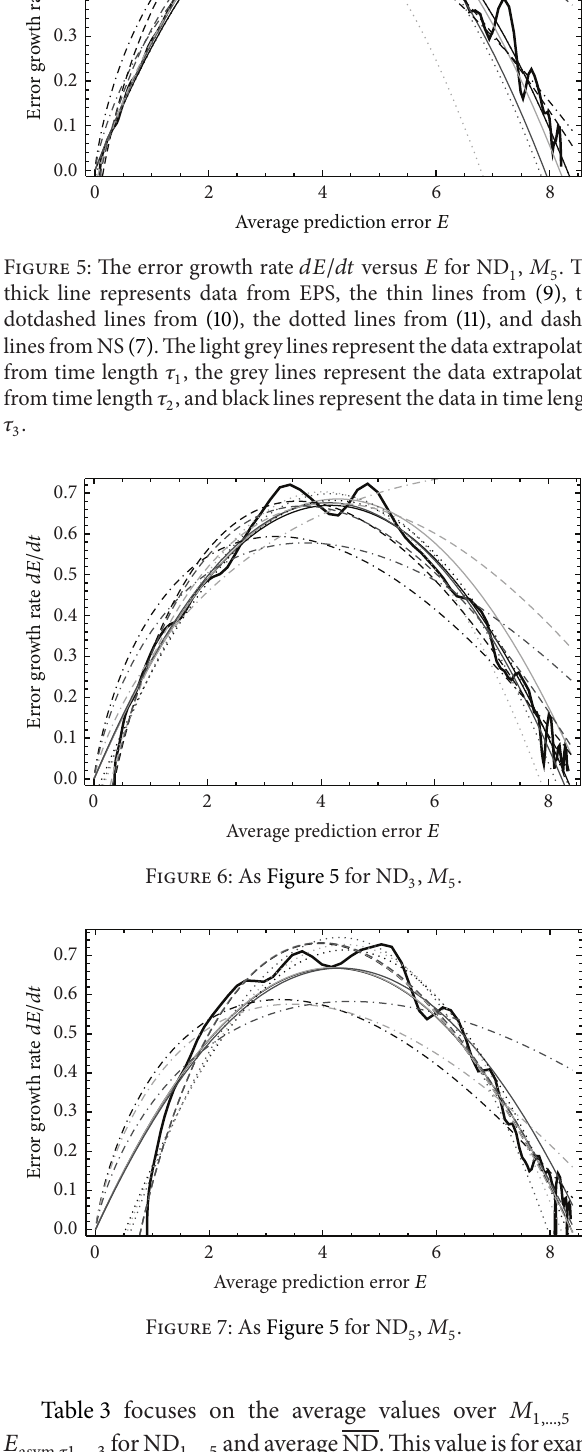
higher than 𝜏 71 % . In the case of values at 𝜏 2 , 𝜏 95 % , 𝜏 1 , 𝜏 71 % and 𝜏 𝜏 1 , 95 % , the highest difference from almost constant values is for 𝜏 1 , 𝜏 95 % and the best results are given by QH with solution (9).